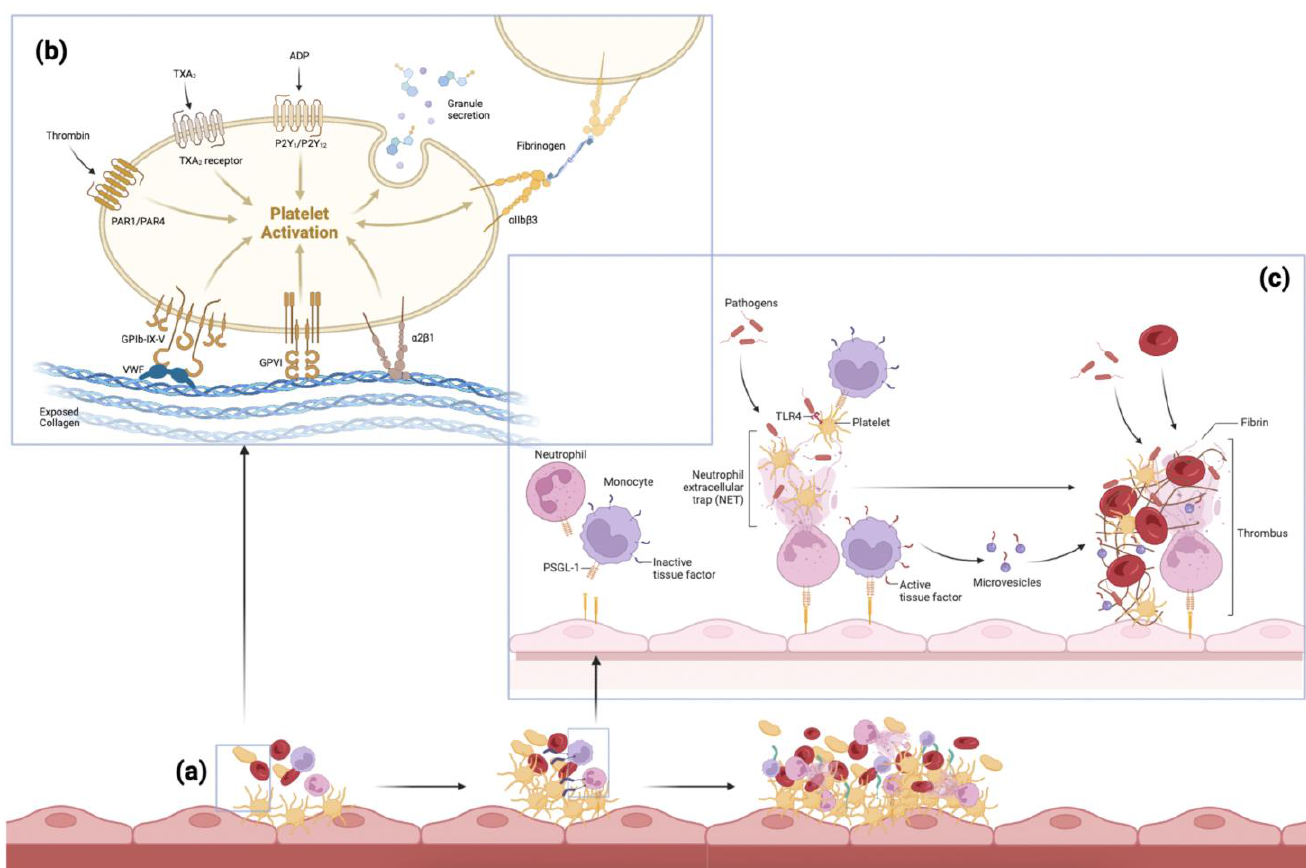
Figure 2. The pathogenesis of thromboembolism. Various pathways implicated in the pathogenesis of thromboembolism: ( a ) The accumulation of thrombotic mediators and cells, starting with primary hemostasis including platelet activation and immuno-thrombosis, followed by secondary hemostasis forming a thrombus. ( b ) The process of platelet activation: exposed connective tissue and collagen cause platelets to change shape and adhere to the vessel wall via pseudopods and platelet receptors. Activated platelets release factors from their granules such as adenosine diphosphate (ADP) (causing nearby platelets to adhere, creating a platelet plug), thromboxane A2 (TXA 2 ) (promoting platelet aggregation and release of more ADP), and thrombin (a strong platelet agonist converting fibrinogen to fibrin). The von Willebrand Factor (VWF) helps platelets adhere via platelet receptor Glycoprotein Ib (GP Ib) on the platelet membrane [28]. ( c ) Neutrophils release neutrophil extracellular traps (NETs), which further promote thrombus formation and help platelet activation. Monocytes express tissue factors on their surface, and aid red blood cell (RBC) recruitment and fibrin formation [29]. Adapted from Engelmann and Massberg (2013) and Bi et al. (2021) [29,31]. Abbreviations: TXA 2 : thromboxane A2; ADP: adenosine diphosphate; PAR: protease-activated receptor; GP: glycoprotein; VWF: von Willebrand factor; NET: neutrophil extracellular trap; RBC: red blood cell; TLR: toll-like receptor; PSGL-1: P-selectin glycoprotein